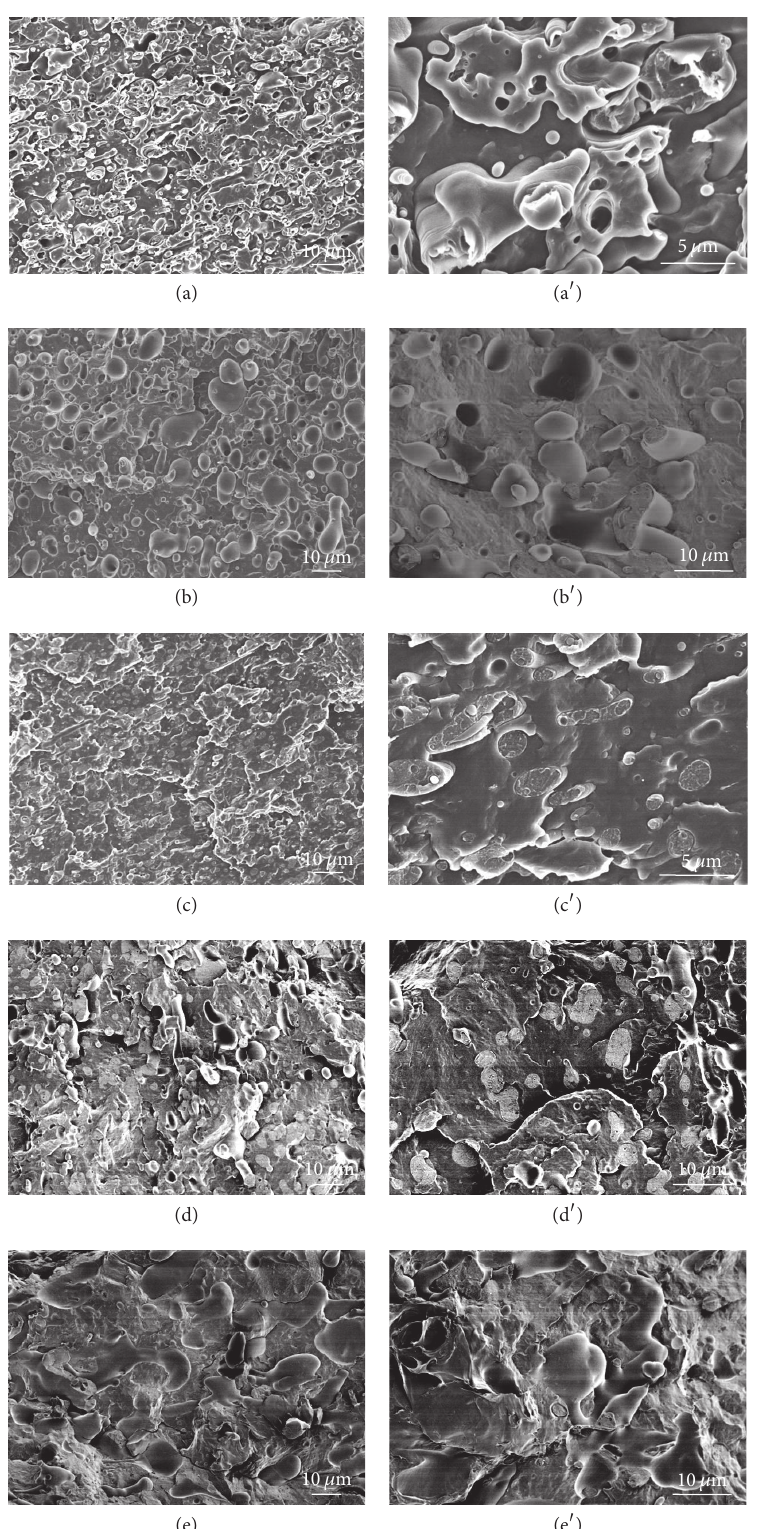
Figure 4: The FESEM images of cross section of [(a) and (a 󸀠 )] aGO/PP/PS, [(b) and (b 󸀠 )] aGO/PP/PS-0.5, [(c) and (c 󸀠 )] aGO/PP/PS-1.0, and [(d) and (d 󸀠 )]